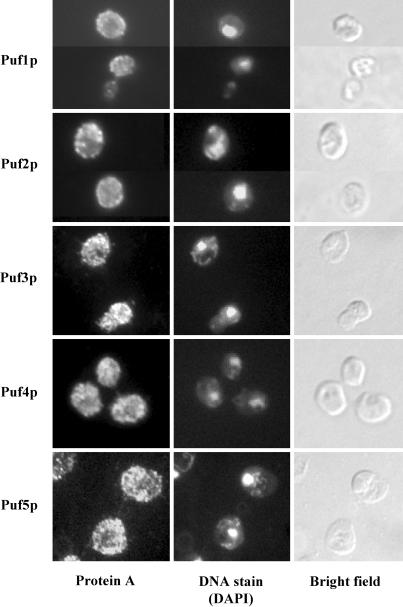
Localization of Puf ProteinsTAP-tagged Puf proteins were visualized in fixed cells. DNA was costained with 4′,6-diamidino-2-phenylindole dimethylsulfoxide (DAPI).